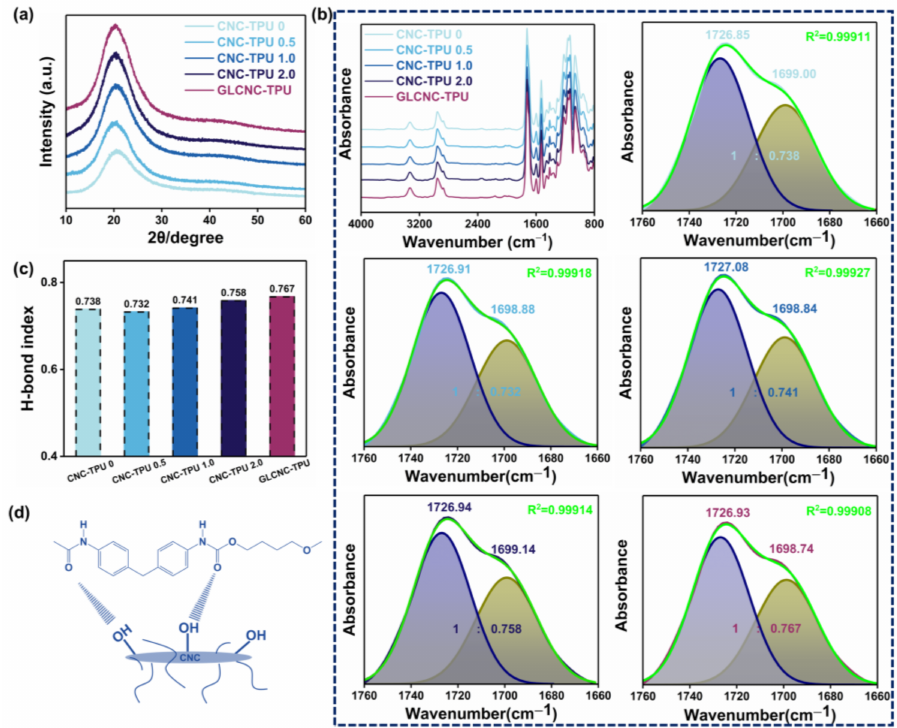
Figure 4. ( a ) XRD patterns of CNC/TPU and GLCNC-TPU composite films; ( b ) ATR-IR spec- tra of CNC/TPU and GLCNC-TPU composite films in the spectral regions 4000–800 cm − 1 and 1760–1660 cm − 1 ; ( c ) H-bond index of CNC/TPU and GLCNC-TPU composite films; and ( d ) schematic illustration of H-boding interactions between CNC and